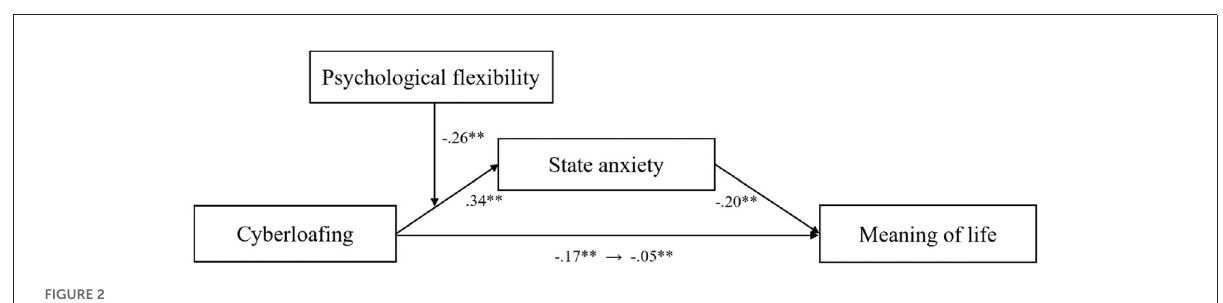
FIGURE2 The moderated mediation